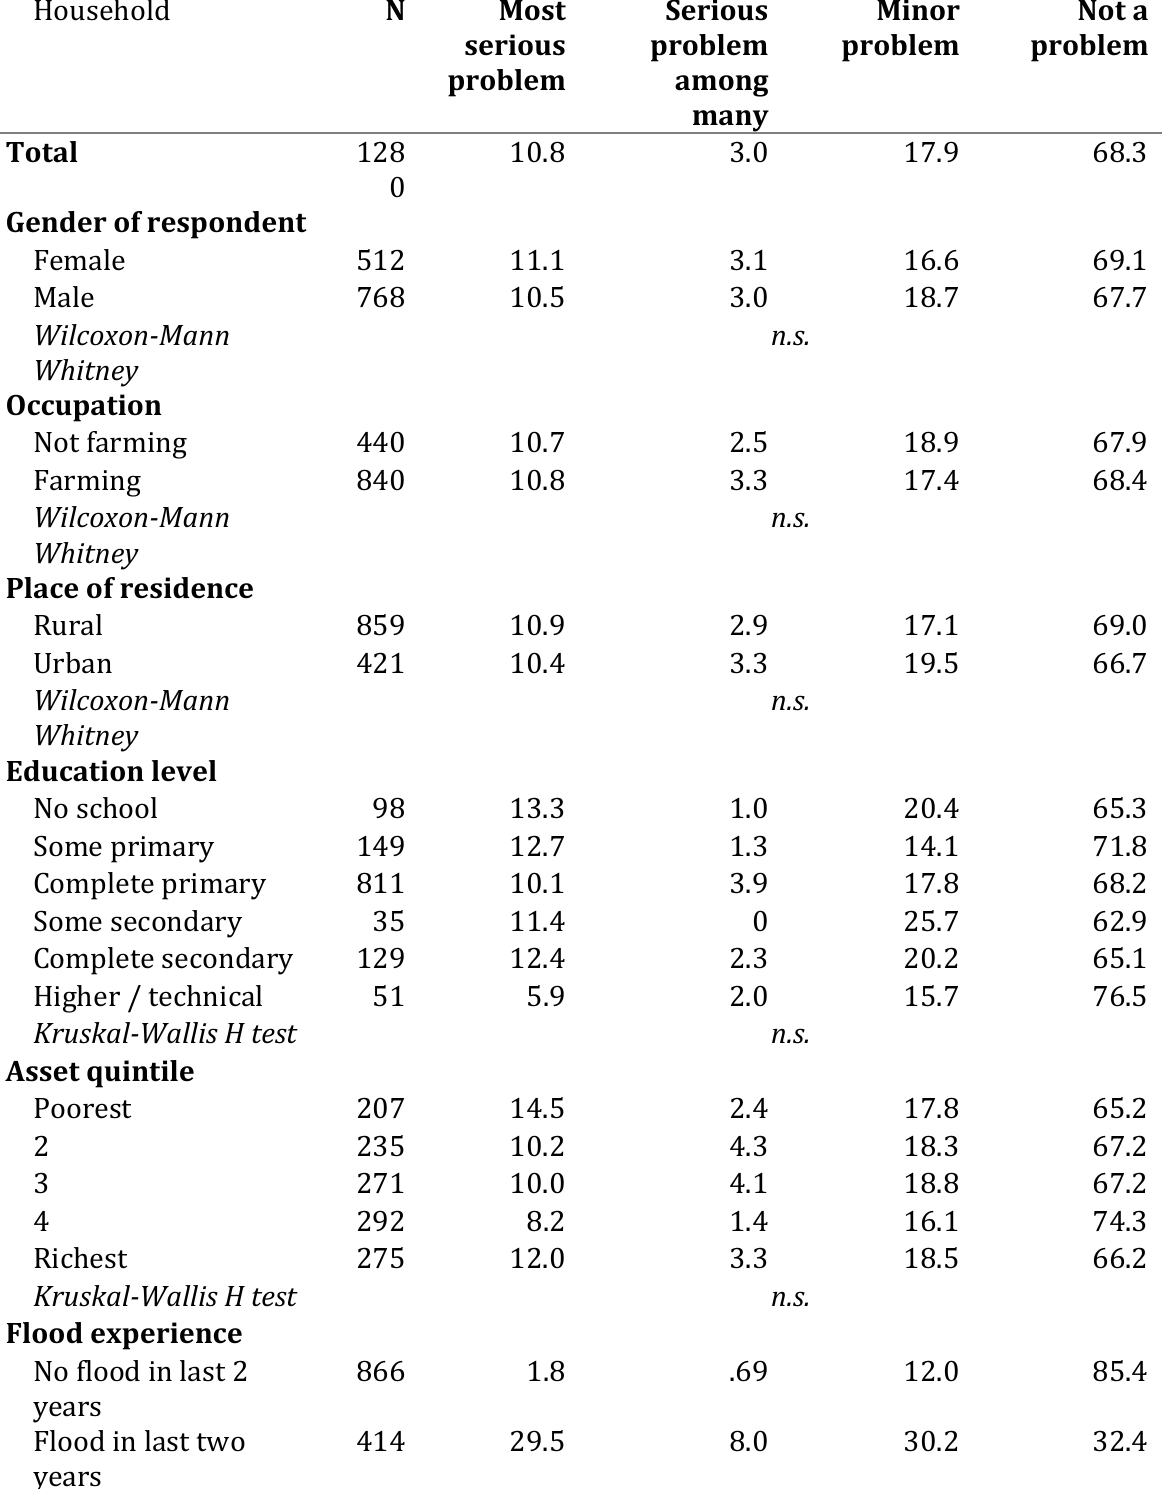
Table A1.2. Respondents’ perceptions of flood severity among their households.